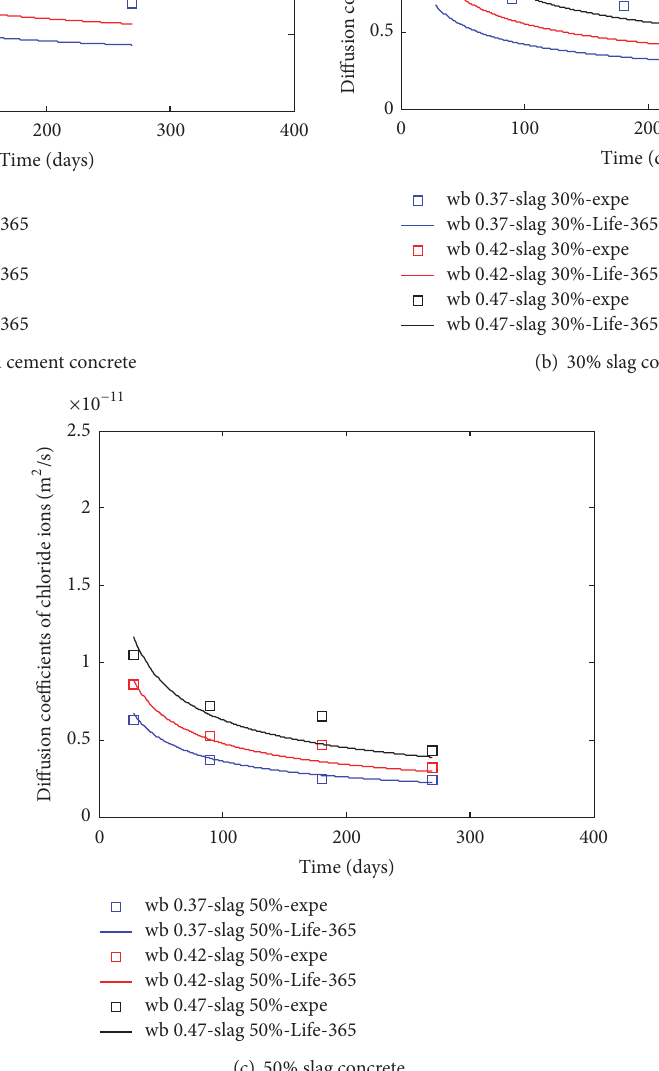
Figure 7: Chloride diffusion coefficients calculated from Life-365